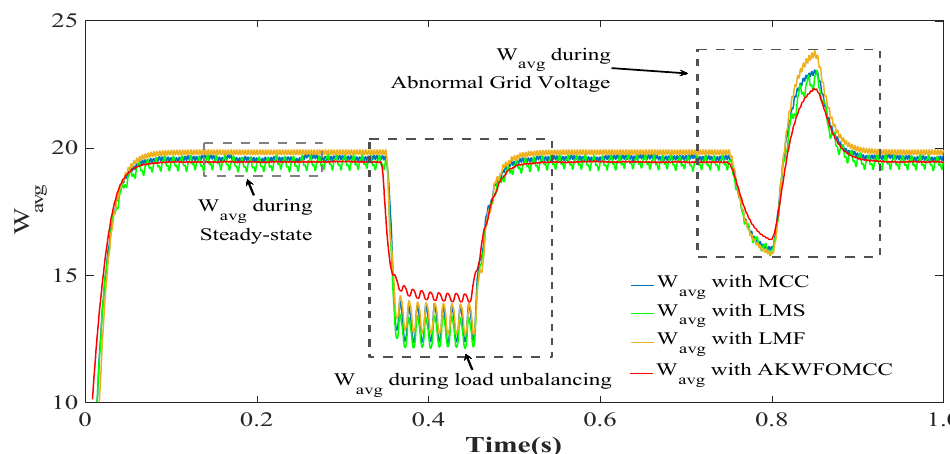
Figure 16. Average weights W avg with AKWSOMCC, MCC, LMF and LMS algorithm.